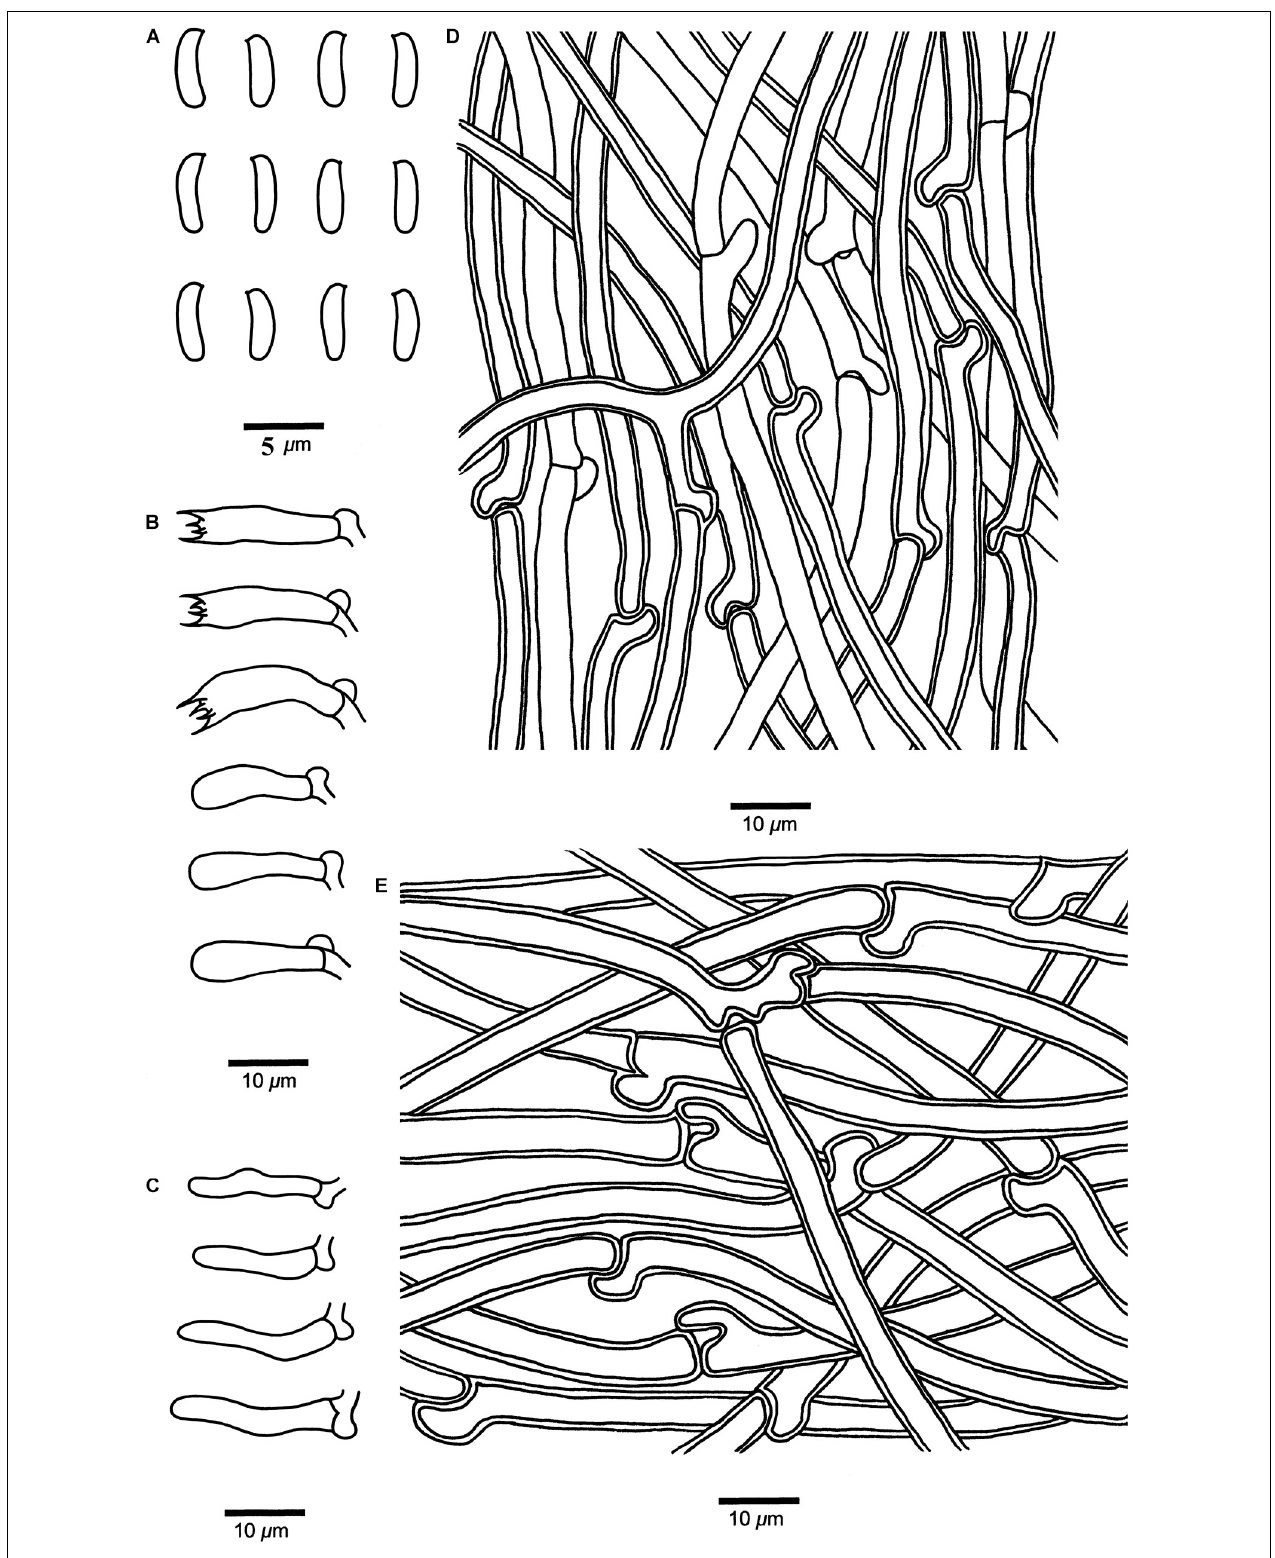
FIGURE 5 | Microscopic structures of Cyanosporus bubalinus (drawn from the holotype). (A) Basidiospores; (B) Basidia and basidioles; (C) Cystidioles; (D) Hyphae from trama; (E) Hyphae from context. Bars: (A) = 5 µ m; (B–E) = 10 µ m.